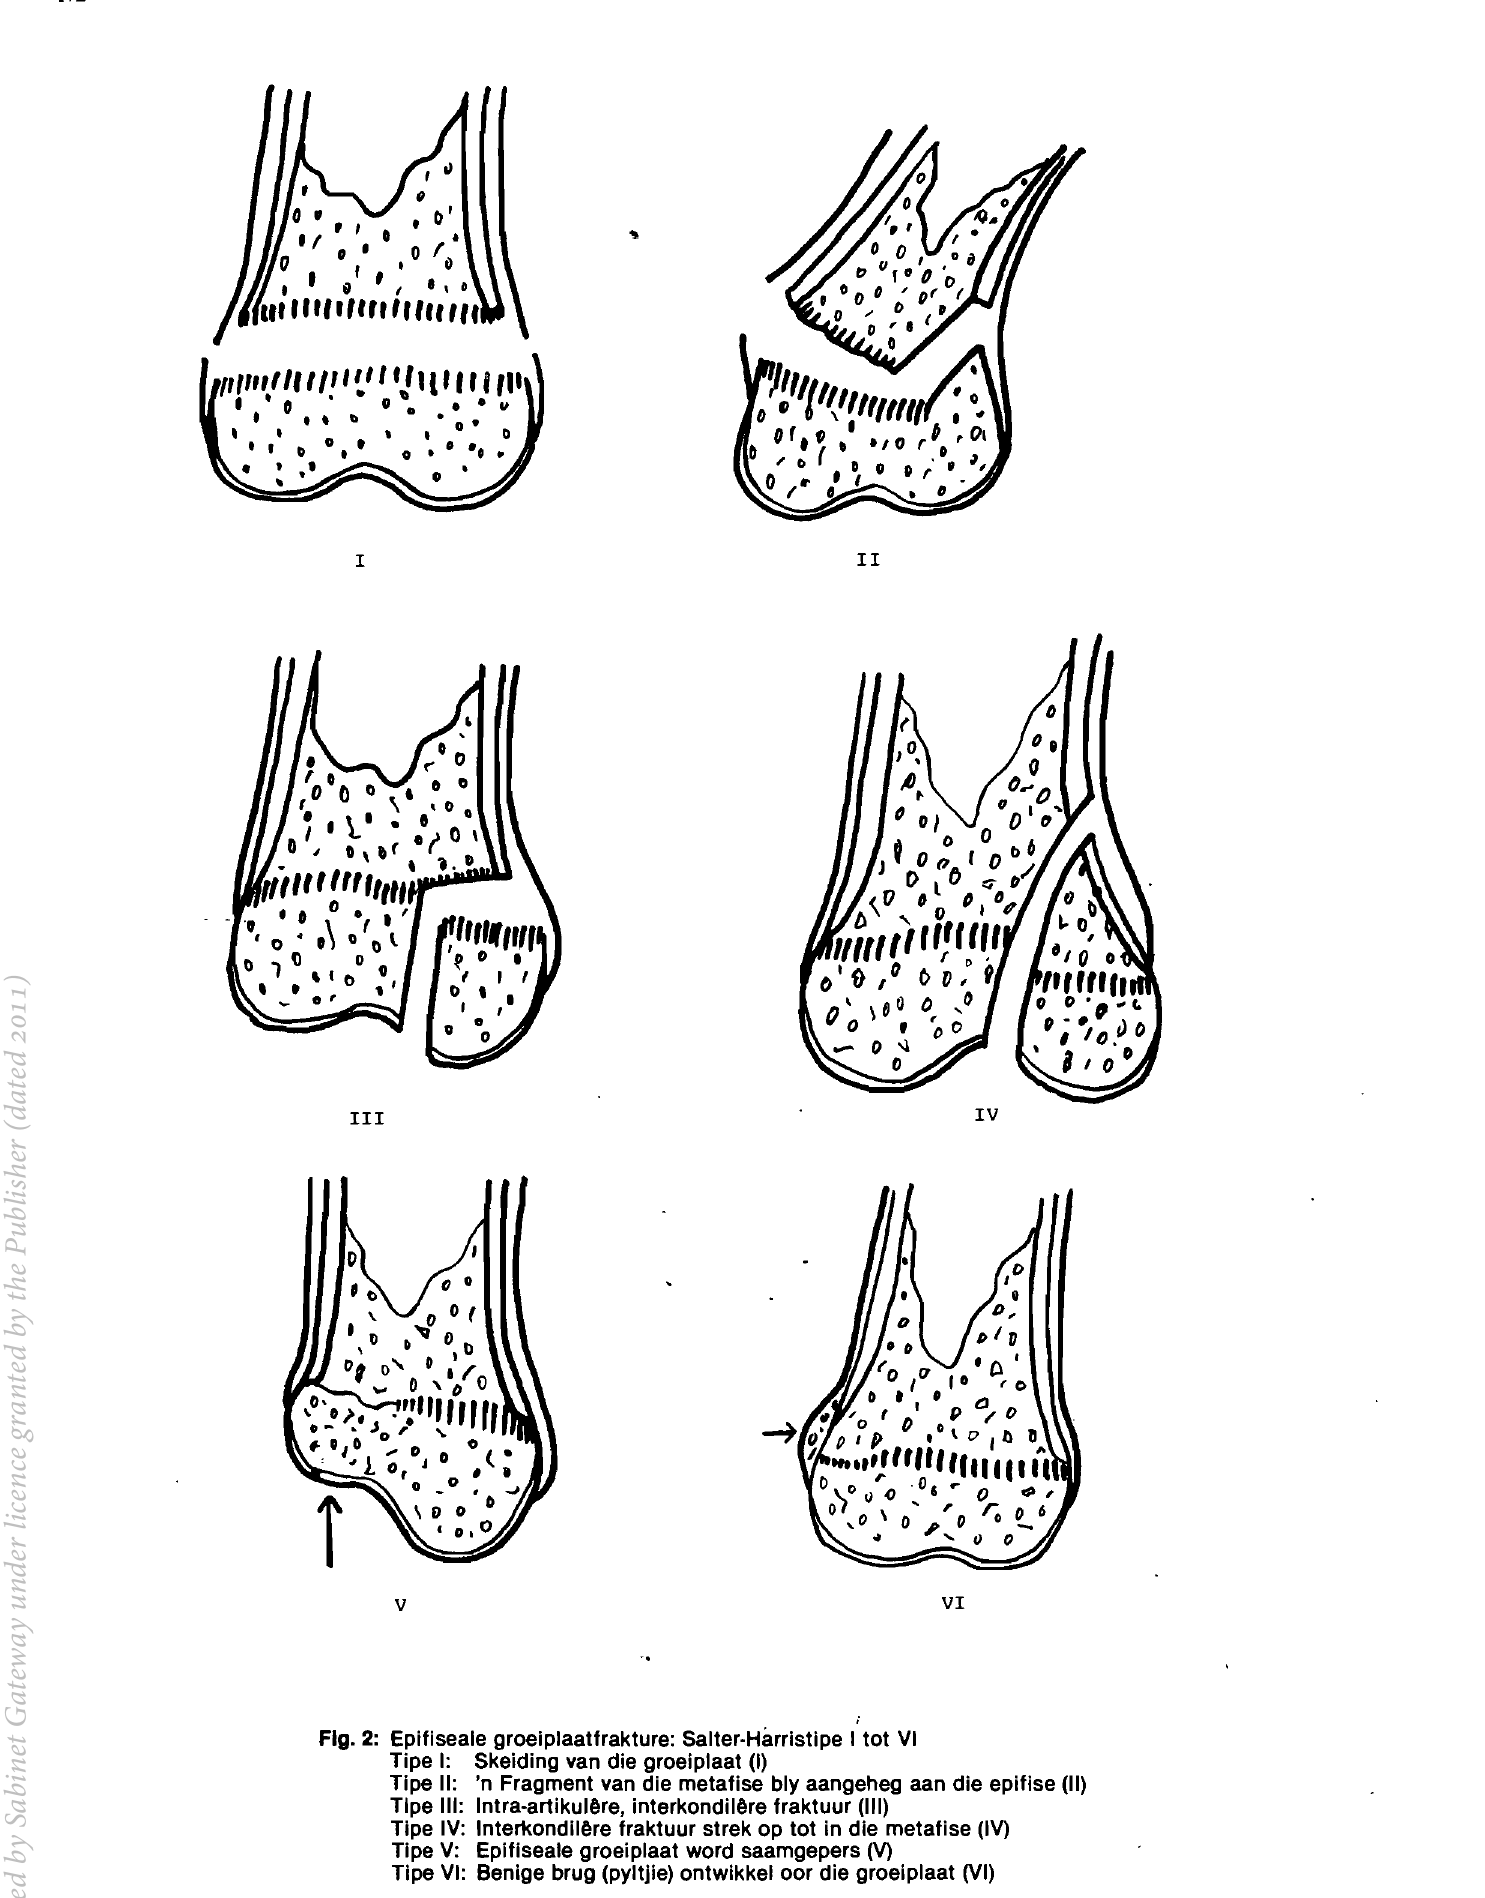
TYDSKRIF VAN DIE SUID-AFRlKAANSE VETERIN£RE VERENIGING-SEPTEMBER